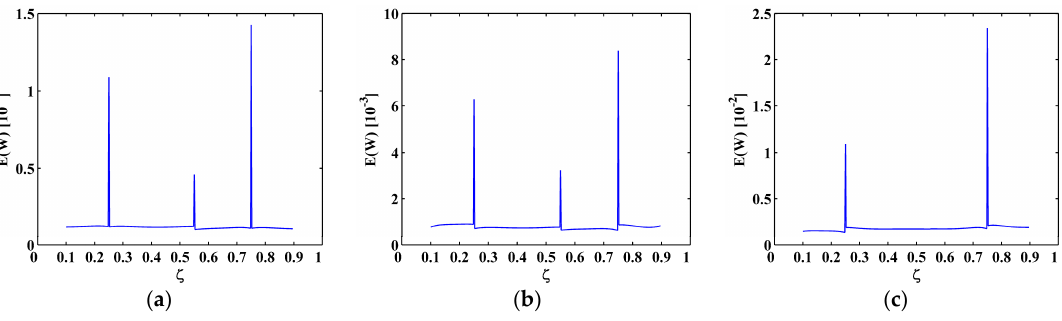
Figure 4. M-TKE for the ( a ) sixth; ( b ) seventh; and ( c ) eighth noise-free mode shapes.